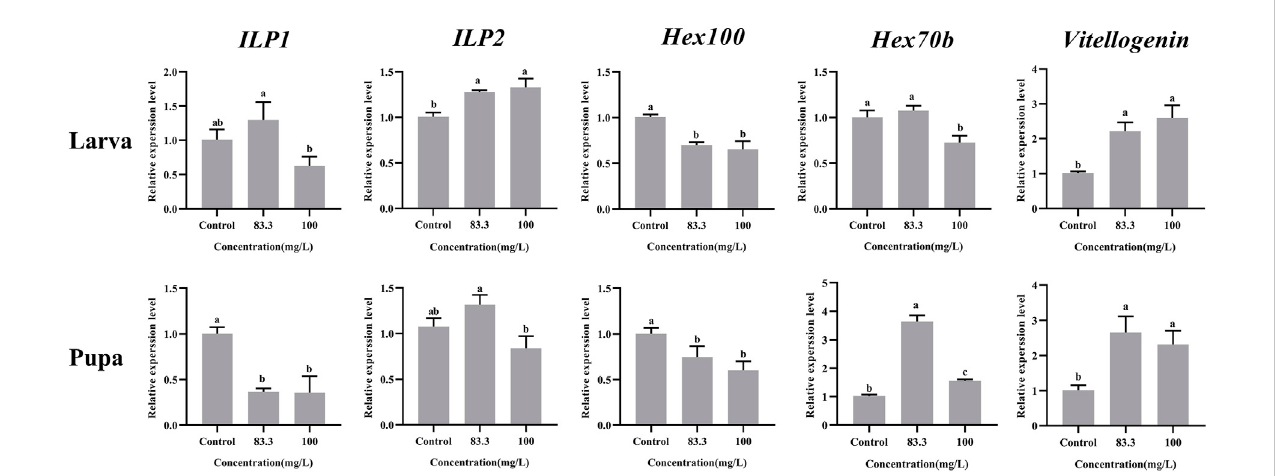
FIGURE 2 Effectsofpyraclostrobinontherelativeexpressionofnutrient-relatedgenes( ILP1 , ILP2 , Hex110 , Hex70b ,and, Vg )in Apismellifera larvaeandpupae.The data in the fi gures are mean ± SE (standard error) and different letters above bars mean signi fi cant difference ( p < 0.05, Fisher ’ s LSD